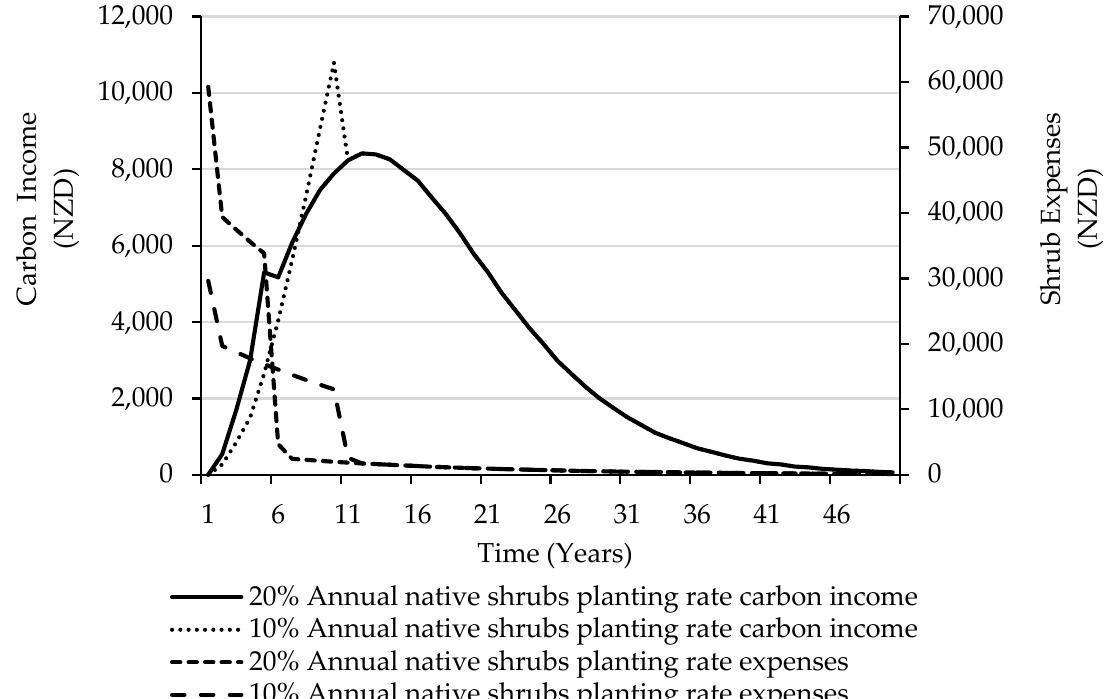
Figure 6. Total native shrub expenses and carbon income discounted at 7% per year over 50 years with native shrubs planted on 10% of the modelled farm at 0%, 10%, and 20% planting rates per year.